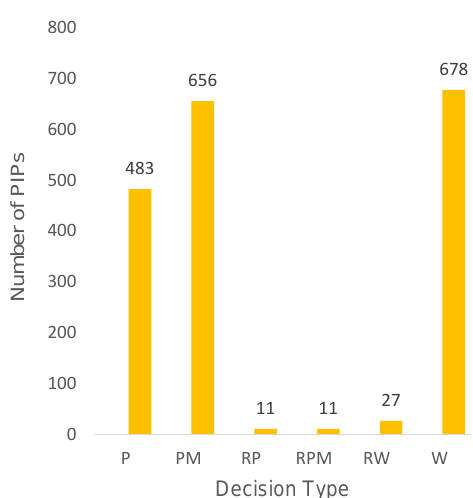
Figure 2. Total number of PIPs agreed by the PDCO, subdivided by decision type (see Table 1), since the EUPR was initiated and until 20 October 2019. Data taken from the EMA repository [20]. See